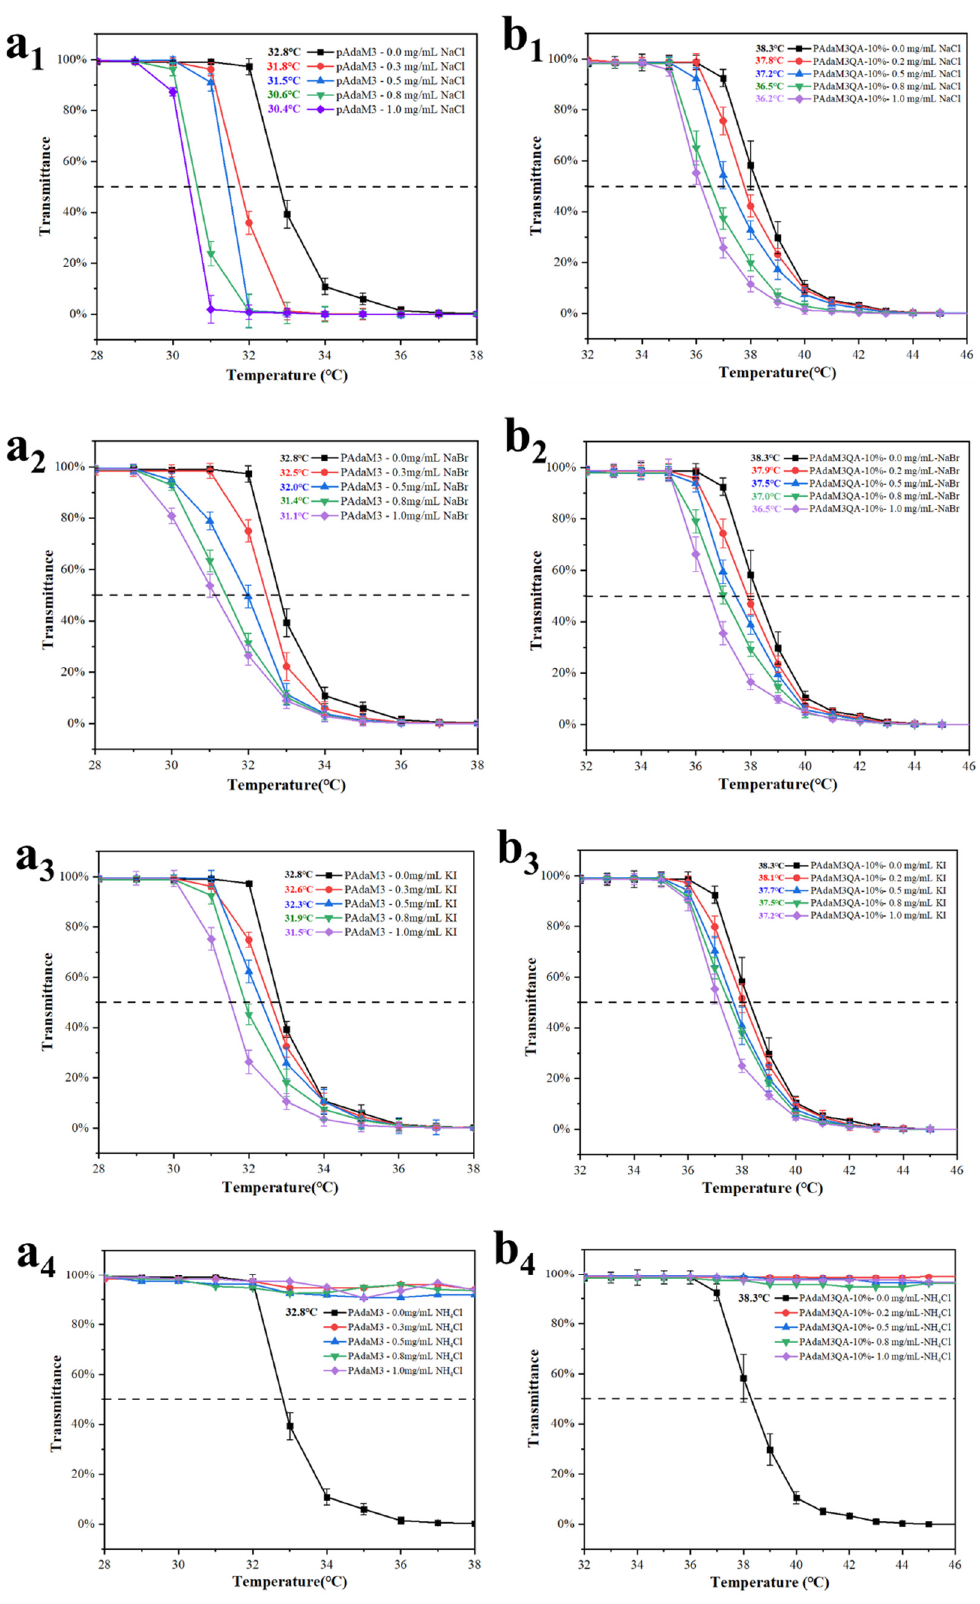
Figure 6. The effect of salt addition on the transmittance of PAdaM3 solution: ( a 1 ) NaCl; ( a 2 ) NaBr; ( a 3 ) KI; ( a 4 ) NH 4 Cl. The effect of salt addition on the transmittance of PAdaM3QA − 10% solution: ( b 1 ) NaCl; ( b 2 ) NaBr; ( b 3 ) KI; ( b 4 ) NH 4 Cl.